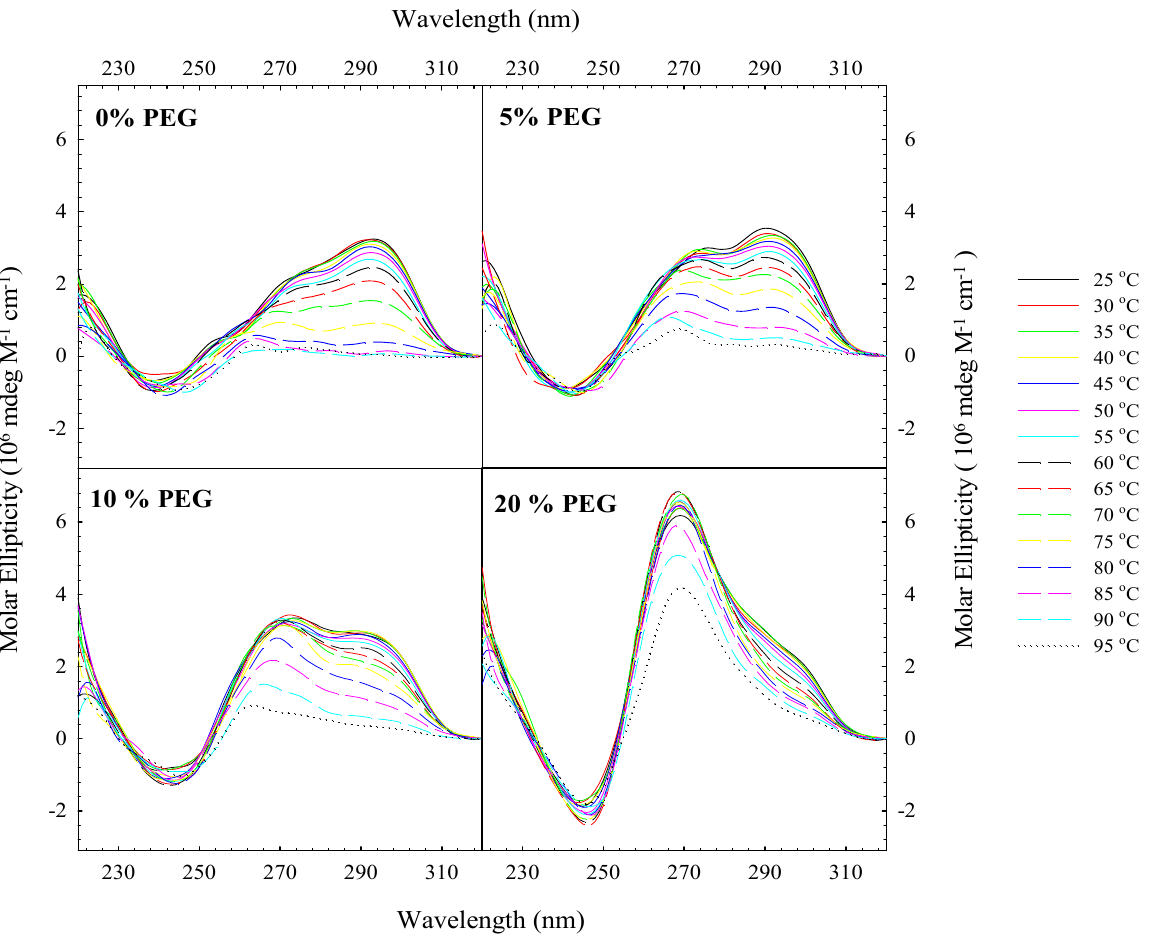
Figure 3. Typical CD optical melting spectra of (TTAGGG) phosphate buffer (115 mM K + ) as a function of percent weight PEG